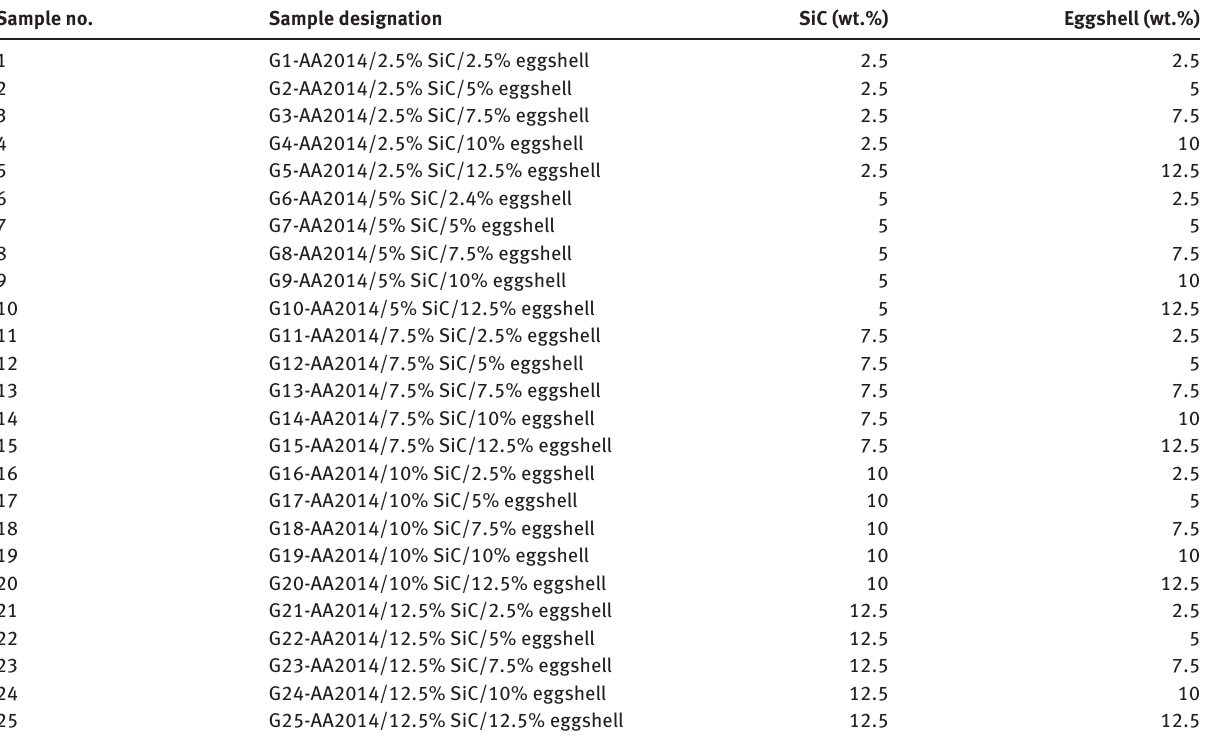
Table 4: Sample designation and reinforcement weight ratio. Sample